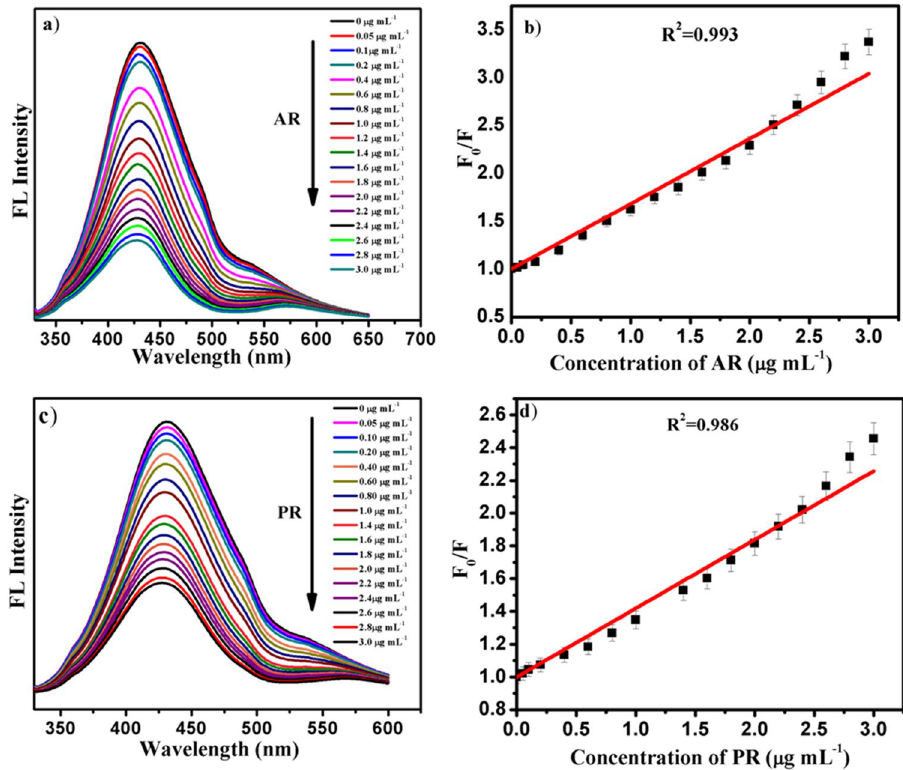
Figure 3. Fluorescence quenching phenomenon of CDS with different concentrations of ( a ) allura red ( c ) ponceau -4R dyes; ( b , d ) are their respective calibration curves.